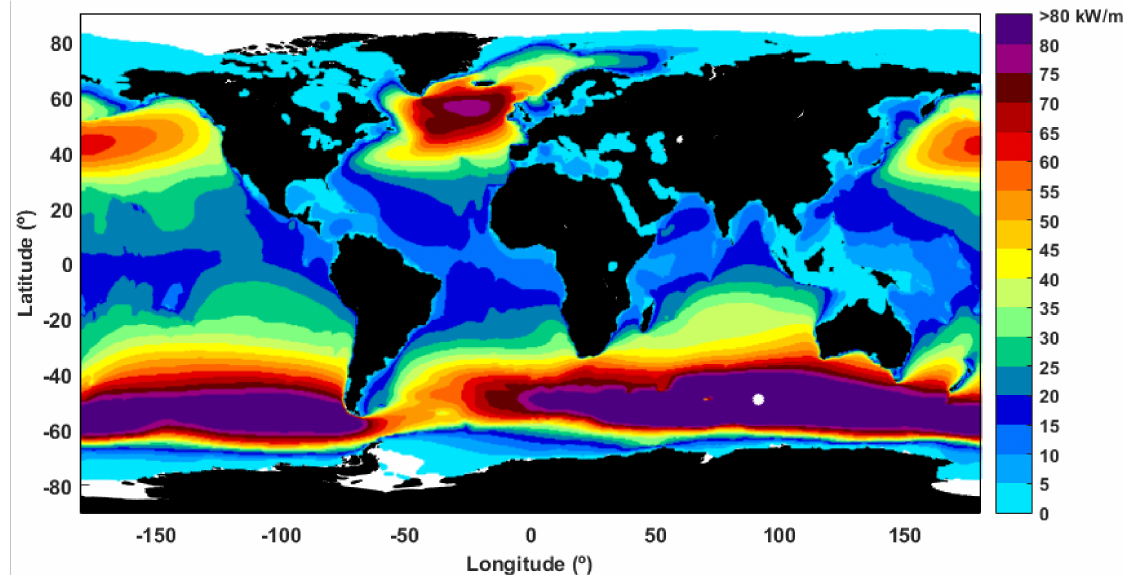
Figure 1. Mean wave power over the 30-year time interval considered (1989–2018) based on date from ERA5 (i.e., ECMWF RE-analysis, fifth